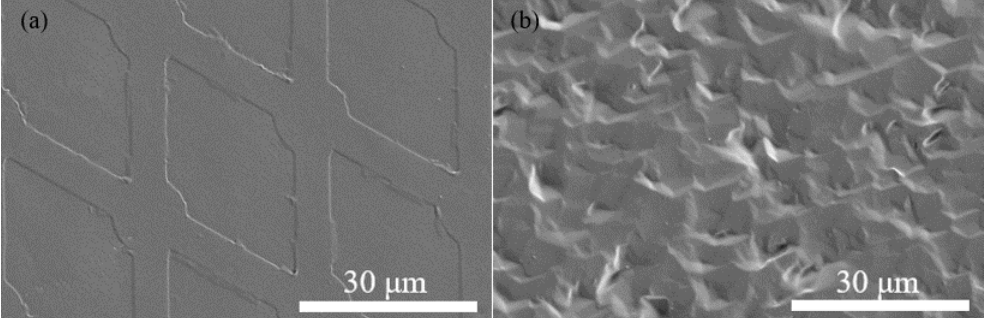
Figure 3. SEM images of the PVA films on the surfaces of the sensors: ( a ) CMUT; ( b ) QCM.